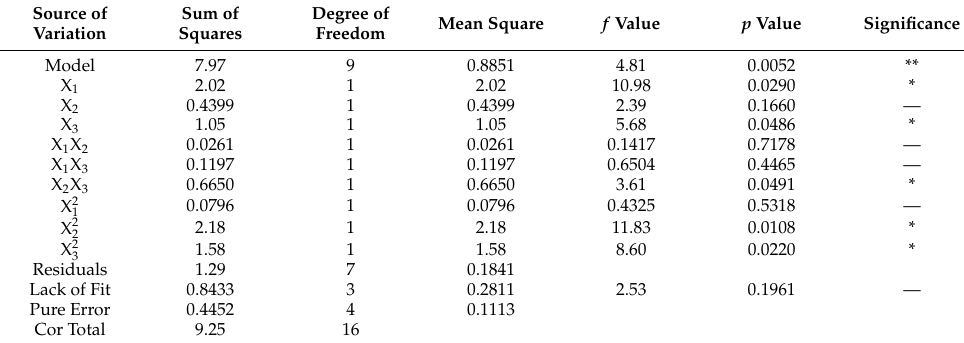
Table 5. Analysis of variance of operating